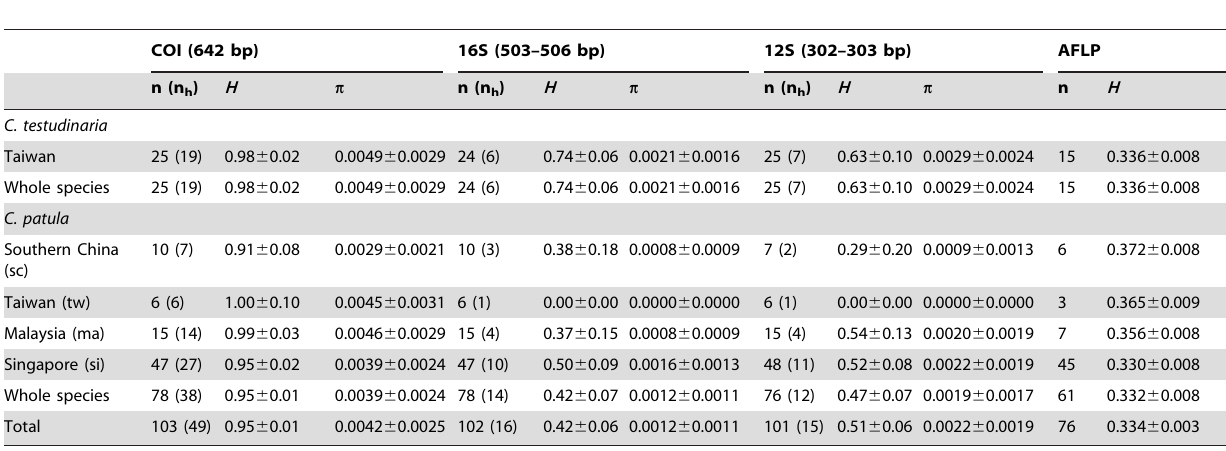
Table 2. Genetic diversity (mean 6 standard error) of Chelonibia testudinaria and C. patula based on mitochondrial COI, 16S, and 12S rRNA markers and AFLP.